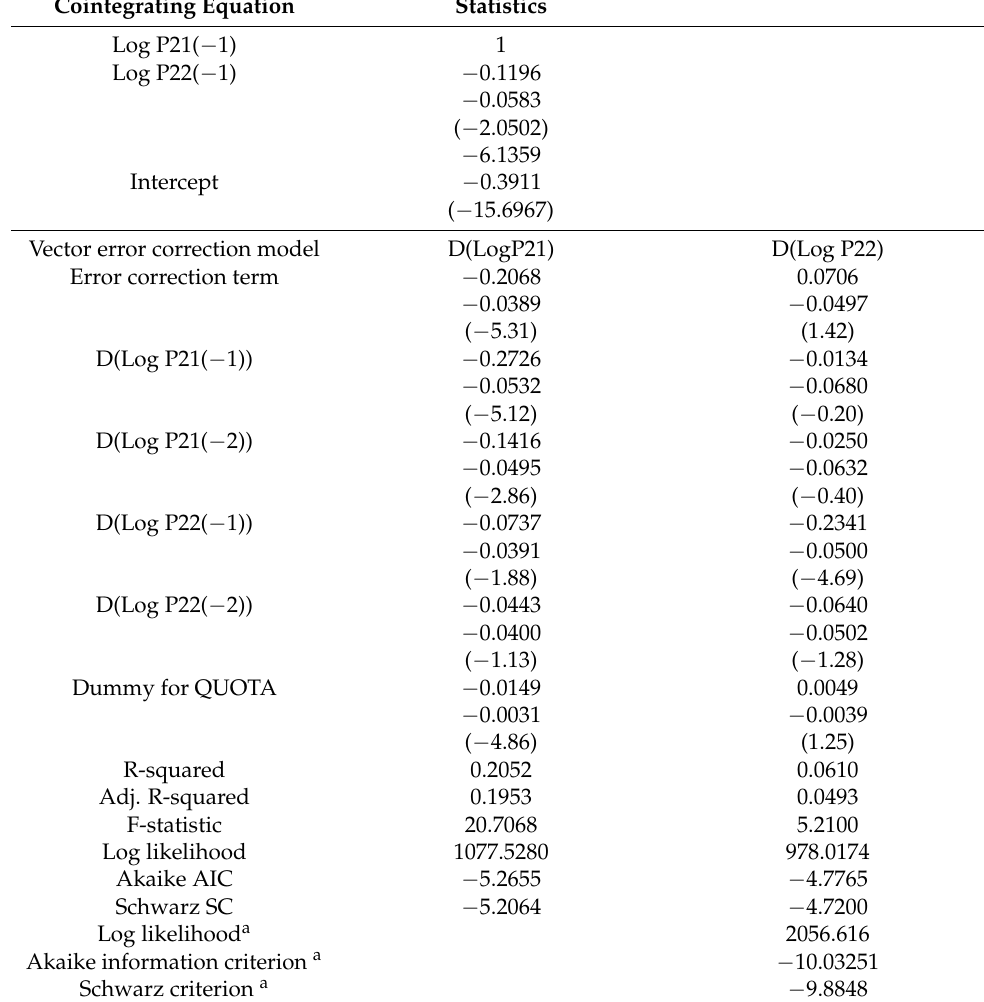
Table 4. Cointegrating equation and Vector Error Correction (VEC) model for prices of curd in the Central region in